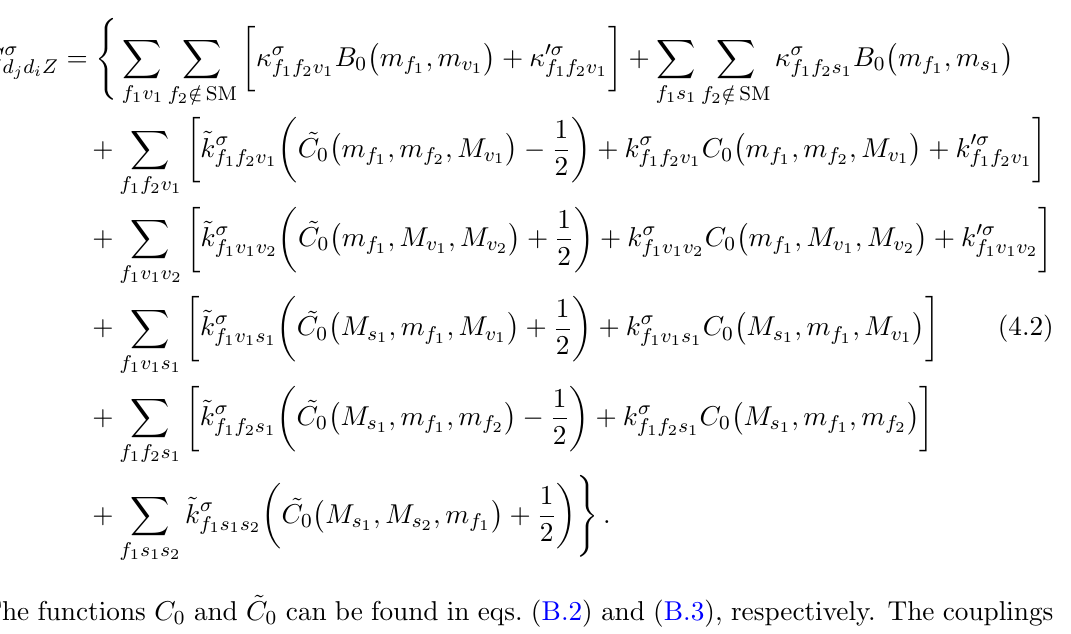
Figure 1 . Representative Feynman diagrams contributing to the one-loop amputated d j Green’s function. Straight lines denote fermions, wavy lines denotes vectors, and dashed lines denote scalar